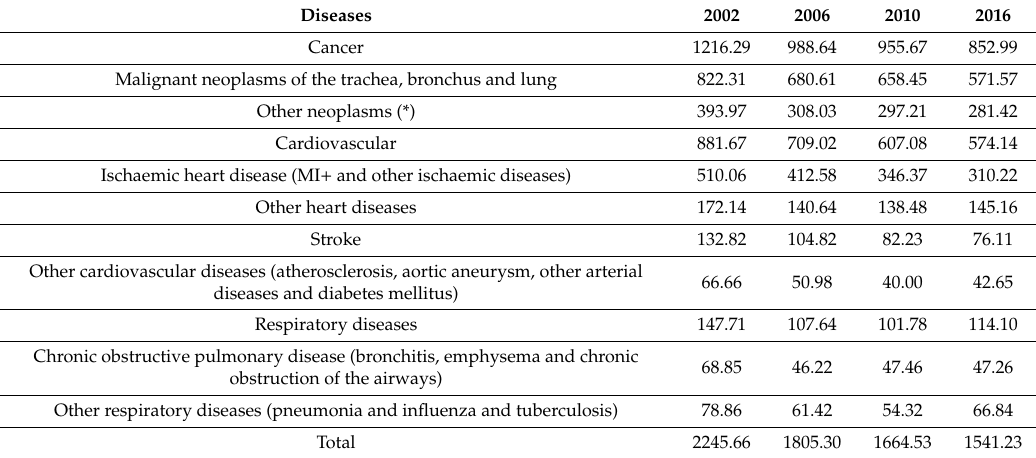
Table A8. Sensitivity Analysis III. Labour losses (constant 2016 euros) (millions of